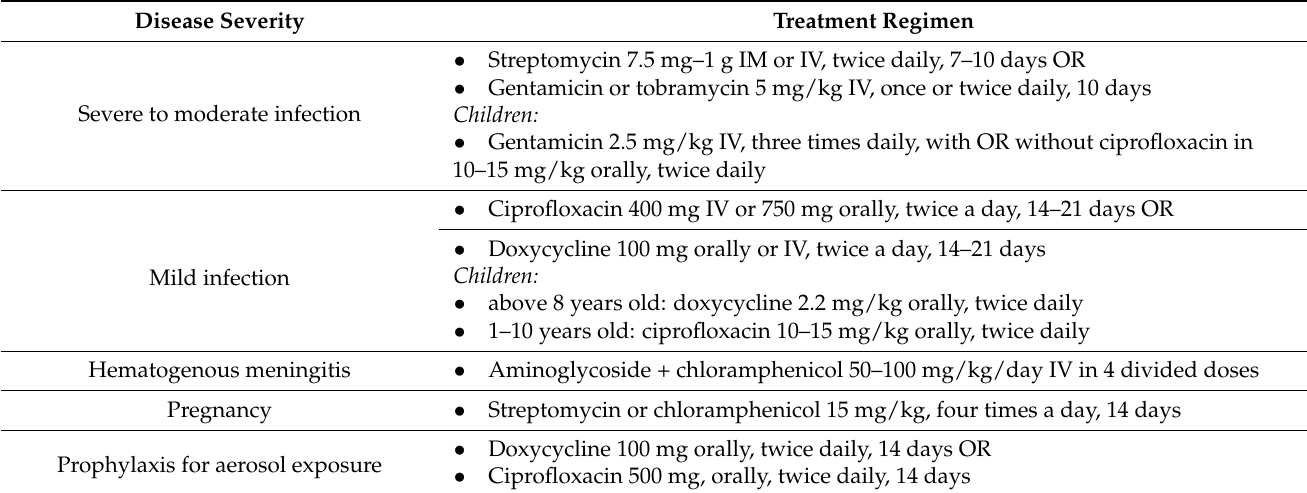
Table 1. Recommended treatment for